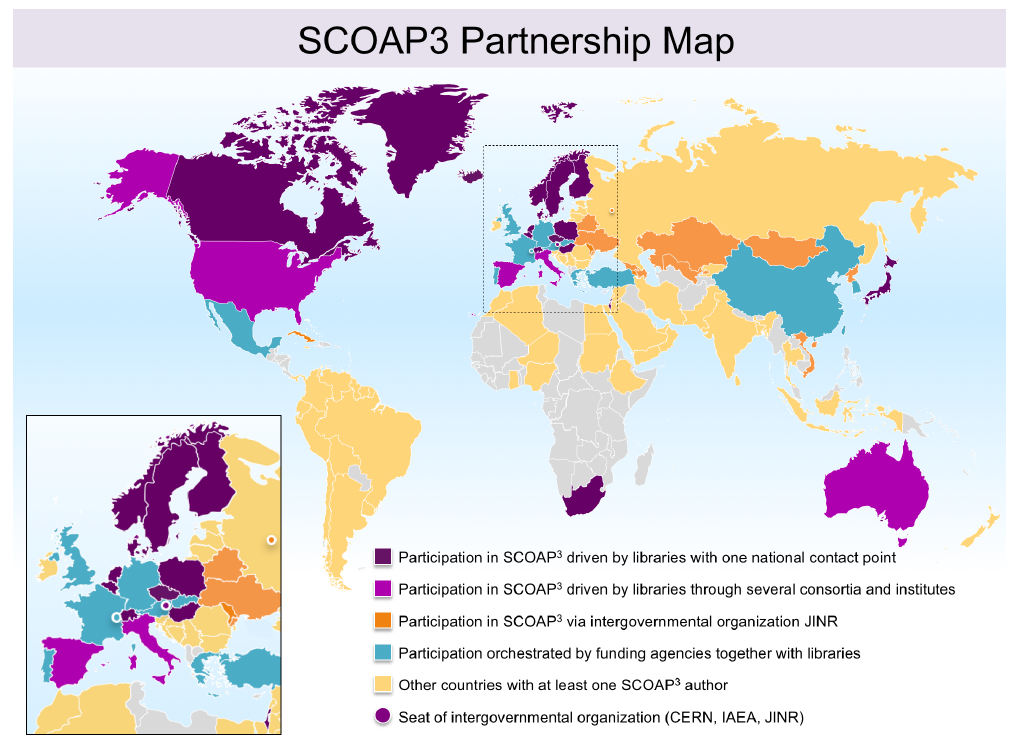
Figure 2. SCOAP3 Partner Countries by type of participation as well as countries with at least one author publishing in SCOAP3 journals (as of February